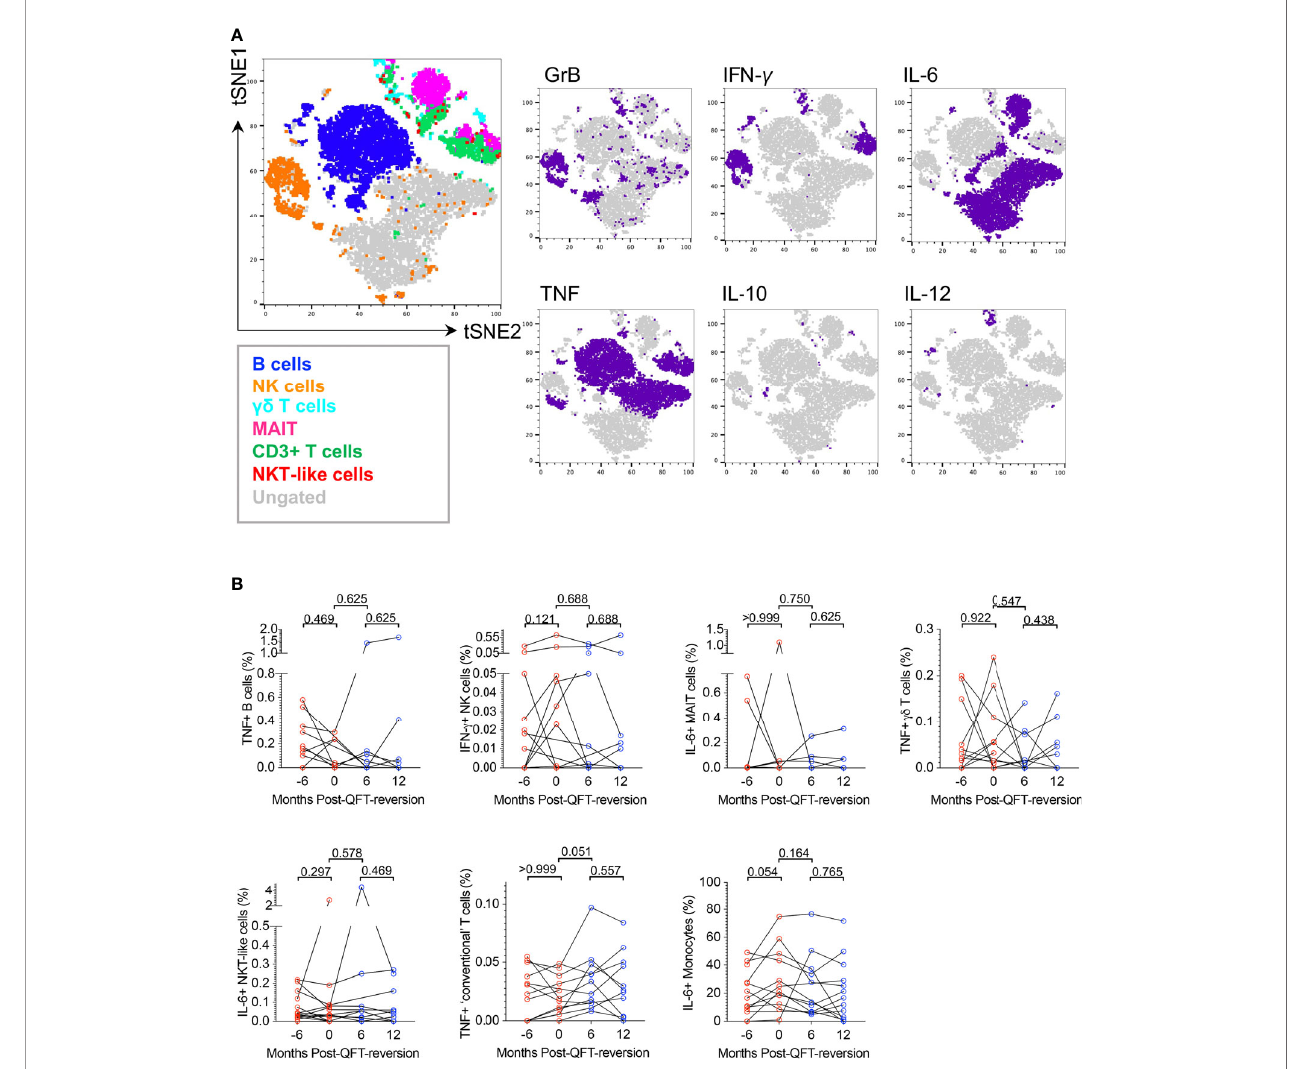
FIGURE 5 | M.tb lysate-reactive innate, DURT and B cell responses do not change upon QFT reversion. (A) tSNE visualization of M.tb-reactive lymphocyte cell subsets expressing any cytokine (Granzyme B (GrB), IL-6, IL-10, IL-12, IFN- g , TNF) in QFT reverters (all visits included). (B) Background-subtracted frequencies of M.tb-reactive TNF+ B cells, IFN- g + NK cells, IL-6+ MAIT cells, TNF+ gd T cells, IL-6+ NKT-like cells, TNF+ T cells and IL-6+ monocytes detected pre- and post- reversion. Month -6: n = 13 (QFT+, red symbol), Month 0: n = 11 (QFT+, red symbol), Month 6: n = 11 (QFT-, blue symbol) and Month 12: n = 11 (QFT-, blue symbol). P values were calculated by Wilcoxon signed rank test and p < 0.017 were considered signi fi